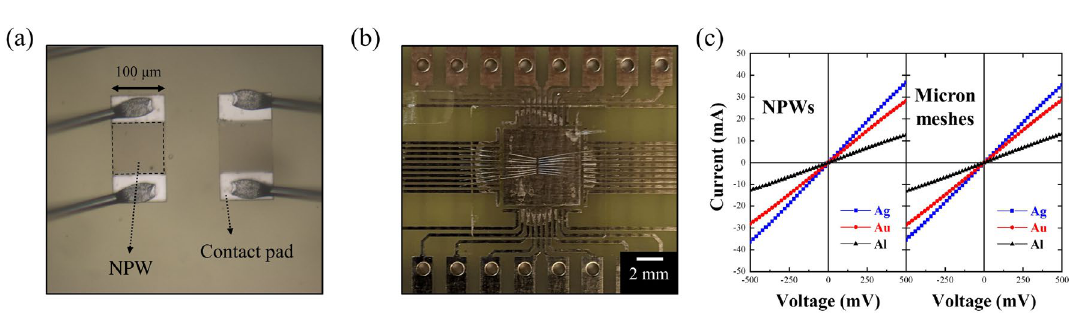
Figure 1. ( a ) Scheme of the mechanism of our proposed nanoscale plasmonic wires (NPWs). By lowering the effective plasmon frequency of the NPWs, we could achieve high optical transparency and good conductivity beyond the plasmon frequency and at direct current, respectively. ( b ) Simulated transmittance (solid line) and reflectance (dashed line) spectra of the NPWs with the periodicity of 500 nm (left panel) and micron-scale metallic meshes with the periodicity of 1000 nm (right panel) for the materials of silver (blue), gold (red), and aluminum (black). ( c ) Measured transmittance spectra of the NPWs (left panel) and the micron-scale metallic meshes (right panel). Note that the packing density of the two is the same for a fair comparison. Here the performance of different metals was examined. Overall, silver outweighs the other two metals in both simulated and measured results.